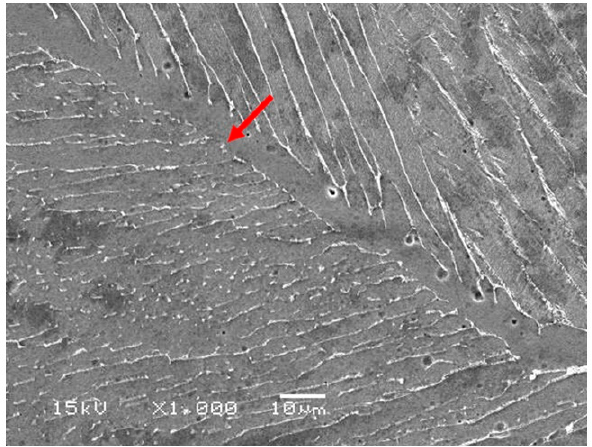
Figure 1. Scanning electron micrographs (SEM) of the as-cast Ti-5Al-2.5Cu alloy (the red arrow indicates the fine Ti 2 Cu precipitate).